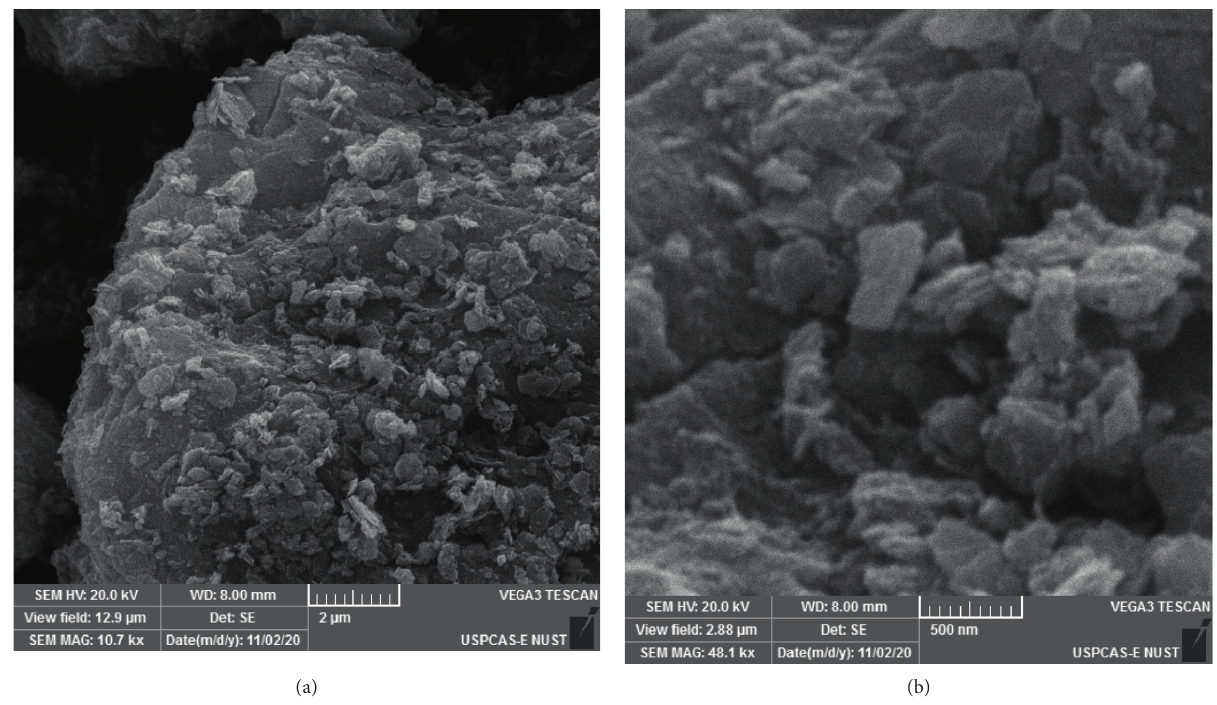
Figure 4: Low (a) and high (b) magnification SEM micrographs of NiO-ZnO